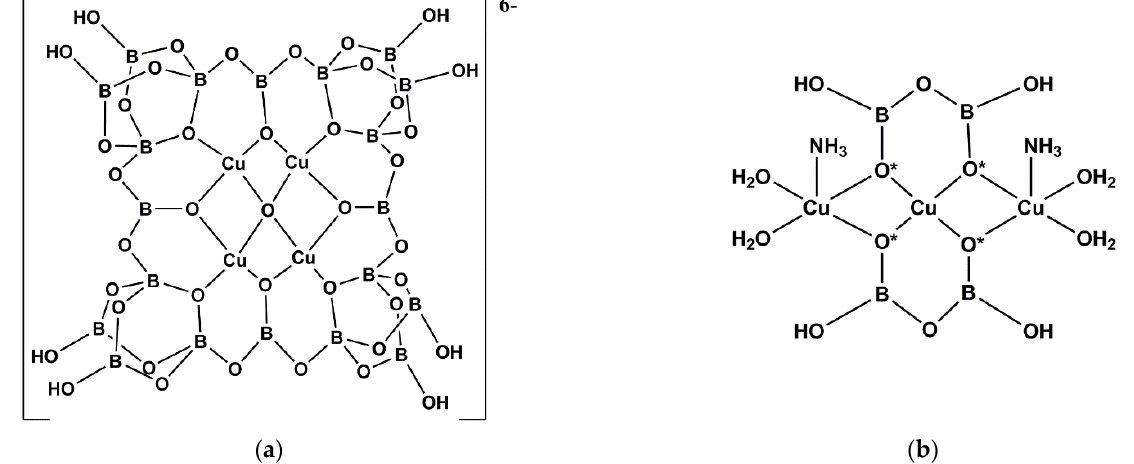
Figure 6. Drawing of ( a ) the structure of the (oxidotetracopper)oxidoicosaborate(6-) anion, [Cu 4 O{B 20 O 32 (OH) 8 }] 6- , found in 13 , 20 and 21 , and ( b ) the ‘top layer’ of 13 which is comprised of a linear {Cu 3 } 6+ chain and two coordinated oxidodiborate(2-), [B 2 O 3 (OH) 2 ] 2- , anions. The four O* atoms also bridge to the four Cu atoms in the lower level of 13 .